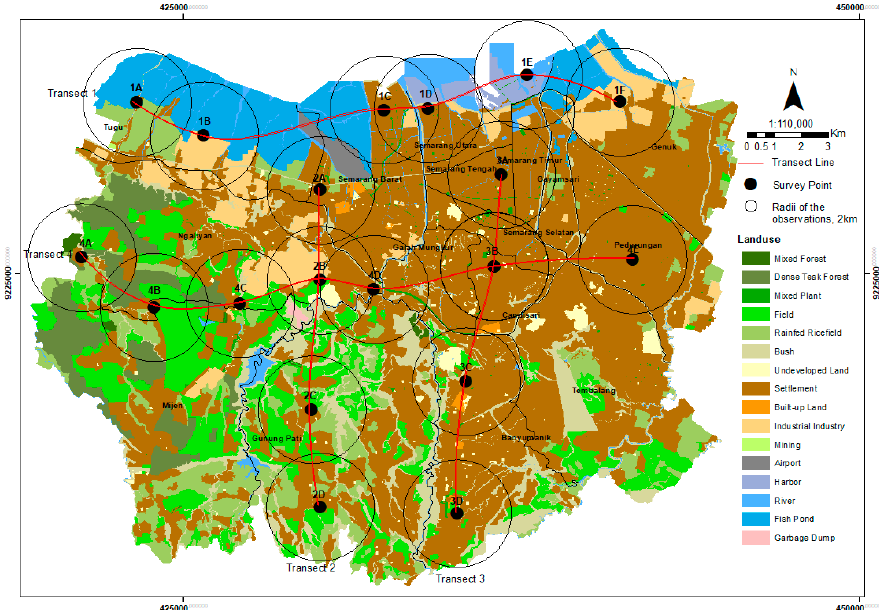
Figure 2. Transect lines, survey points, and radius of observation used in the data collection.